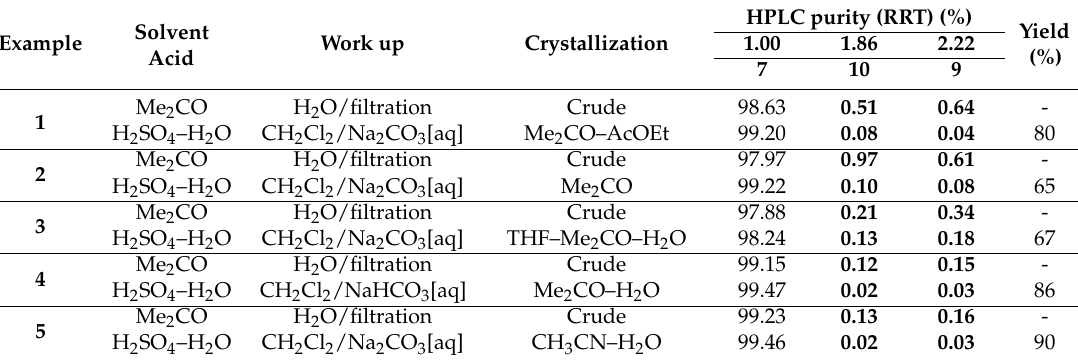
Table 2. Synthesis and HPLC data of olmesartan medoxomil (OM, 7 )